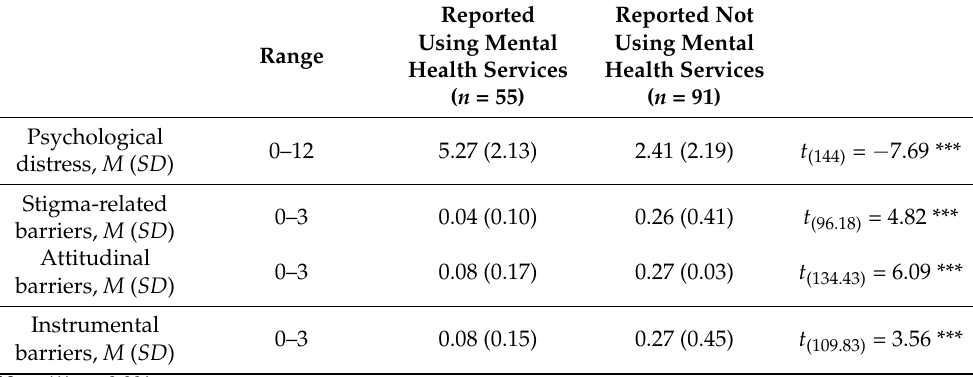
Table 2. Differences between Service Users and Non-Users in Stigma-Related, Attitudinal, and Instrumental Barriers.